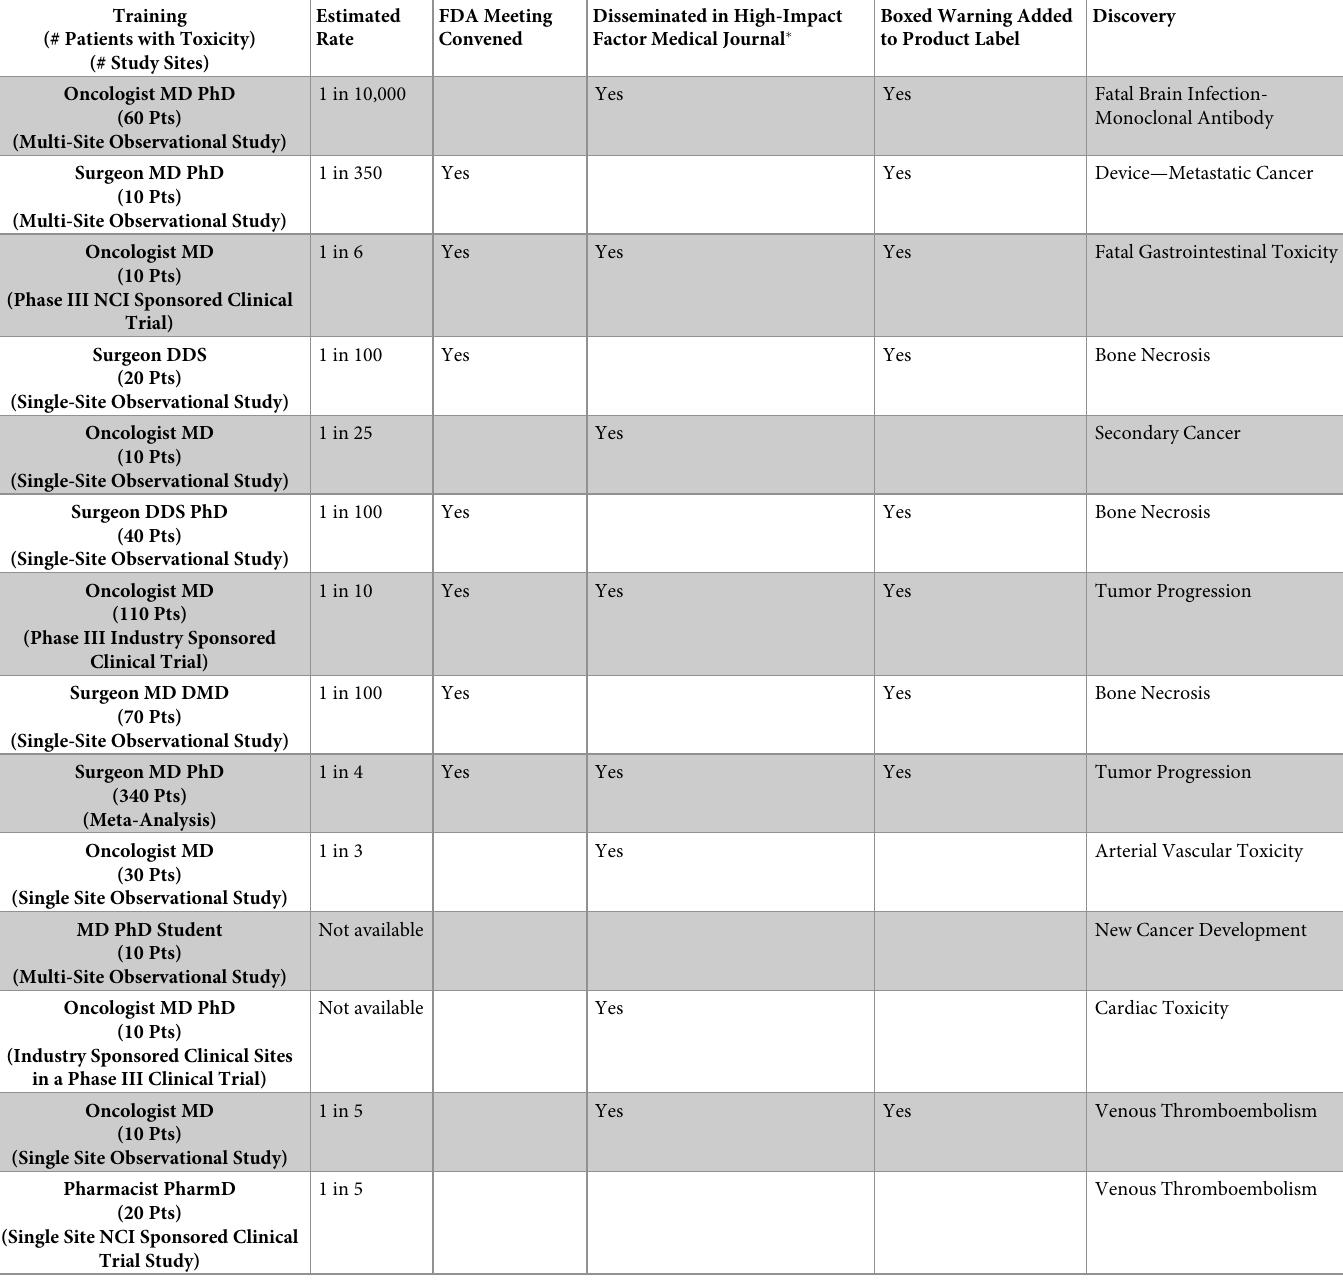
Table 1. Table of adverse drug